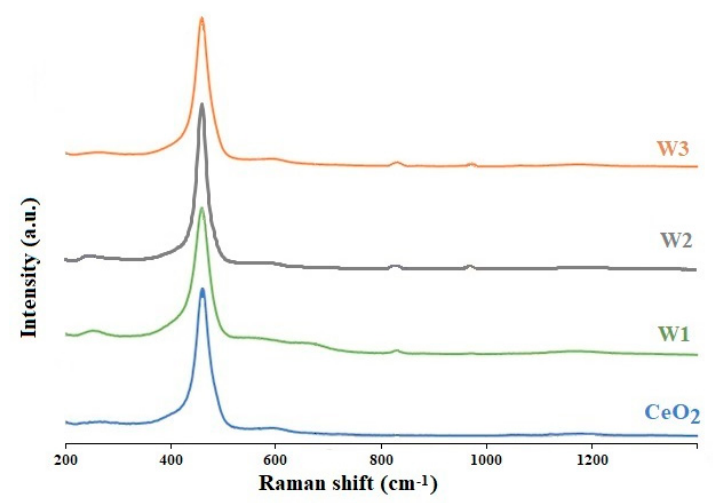
Figure 2. Raman spectra of ceria and powder catalysts: W1, W2 and W3.